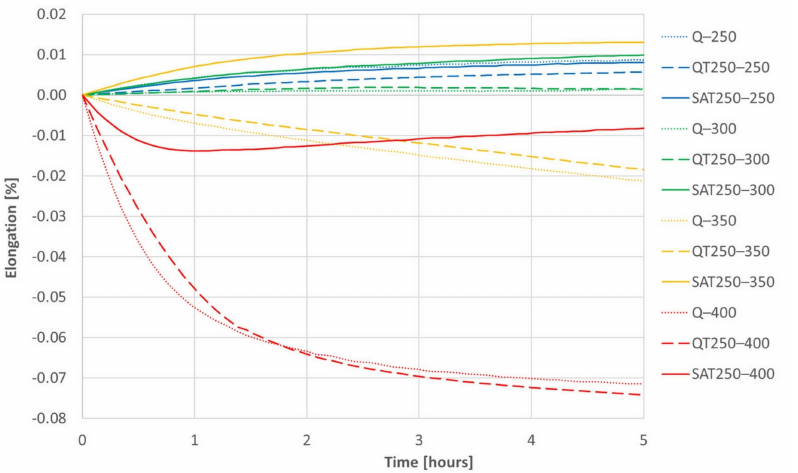
Figure 14. The series of dilatometric records of isothermal tempering of samples after quenching (dot- ted lines) or quenching and one tempering (dashed lines) or quenching, tempering and deformation (solid lines).